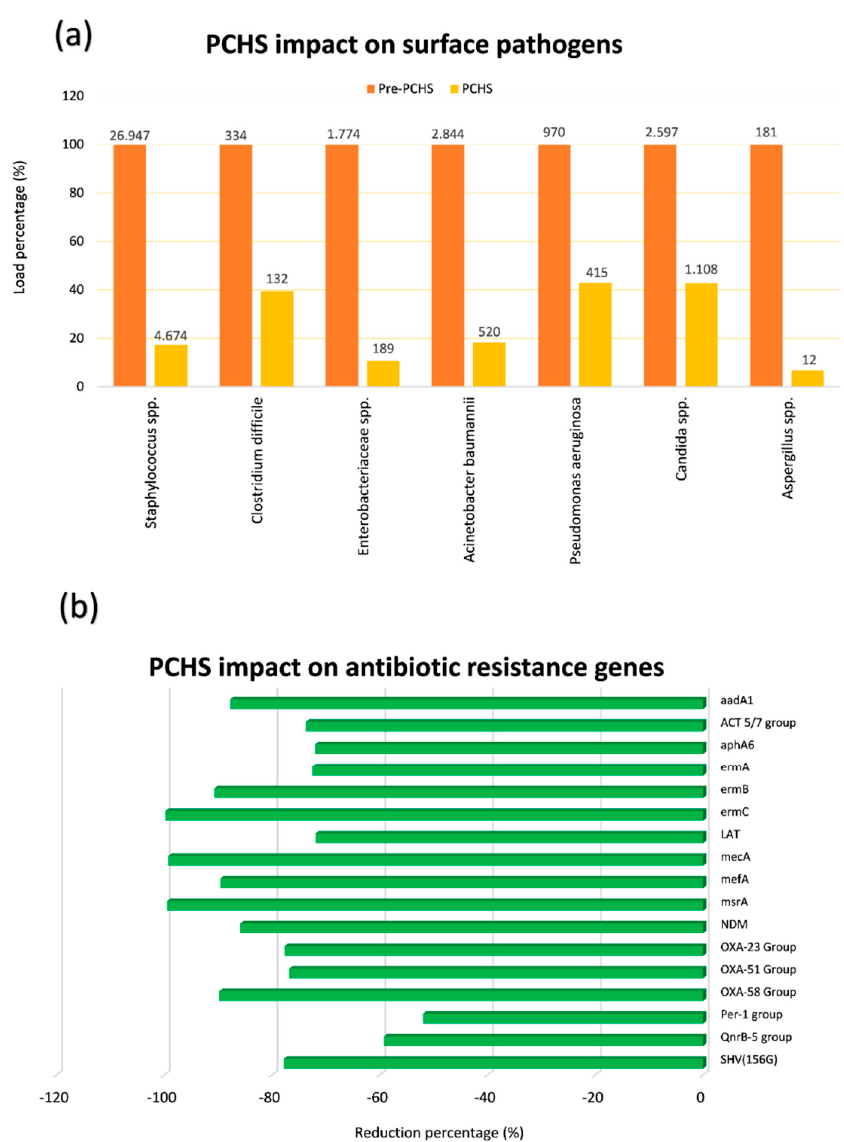
Figure 2. Probiotic Cleaning Hygiene System (PCHS) effect on microbial contamination and its antimicrobial-resistance (AMR) characteristics on hospital surfaces. ( a ) Six healthcare-associated infections (HAI)-associated pathogens were measured by Colony Forming Unit (CFU) count on hospital surfaces of five Italian hospitals before and after PCHS introduction; microbial load is expressed as percentage for each individual analyzed pathogen (mean values per m 2 are also displayed); ( b ) the resistome of contaminating microbial population was analyzed by qPCR microarray before and after PCHS introduction; the most prevalent antibiotic-resistance genes are reported, and expressed as percentage reduction of genes during the PCHS phase compared to pre-PCHS phase.